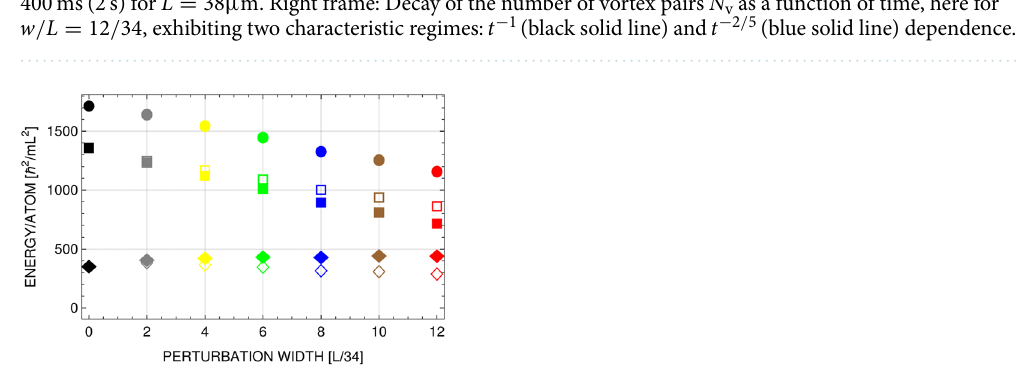
Figure 6. Total (circles), interaction (squares), and kinetic (diamonds) energies per atom as a function of perturbation width, as in Fig. 5. Open symbols represent initial energies while the solid ones are energies 0.2mL 2 / (cid:31) , deeply in plateau region (total energy is conserved as the system is isolated). A calculated at t = small rise in kinetic energy per atom, which is a measure of temperature of the system, is observed. Then, the increase of temperature T and the reduction of the critical temperature T c results in increase of the relative temperature T / T c , shown by vertical lines in Fig. 5 (left